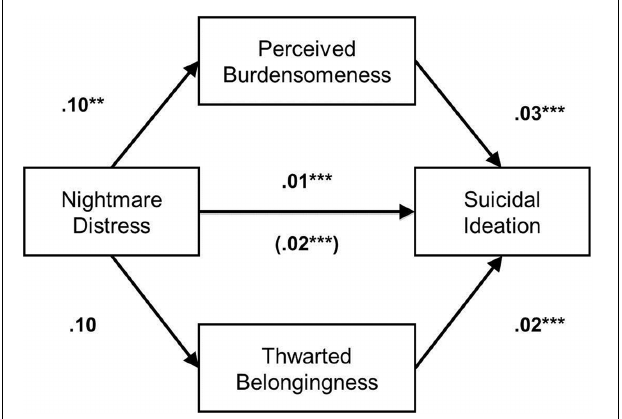
FIGURE 1 | Unstandardized path coefficients are presented with standard errors in parentheses. The indirect effect of nightmare distress on suicidal ideation through perceived burdensomeness was significant (Bootstrapped 95% CI ranged from 0.0009 and 0.0099), but not thwarted belongingness (Bootstrapped 95% CI ranged from 0 and 0.0074). ∗∗ p < 0.01, ∗∗∗ p <